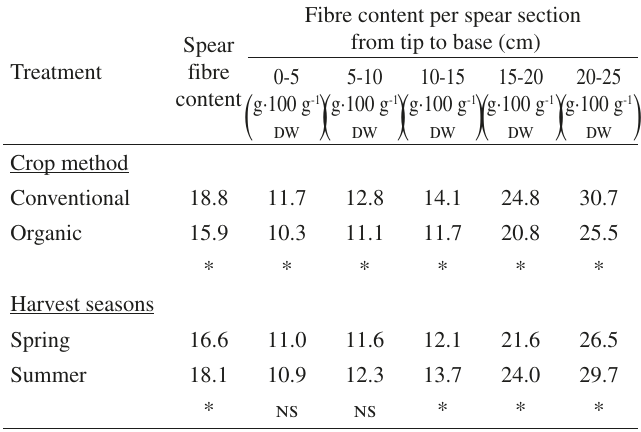
Table 5 - Asparagus spear fibrousness as influenced by crop method and harvest